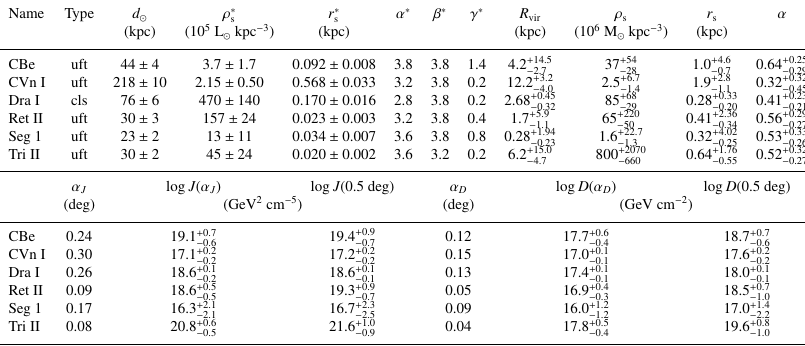
∗ s , radius r s and profile indexes;